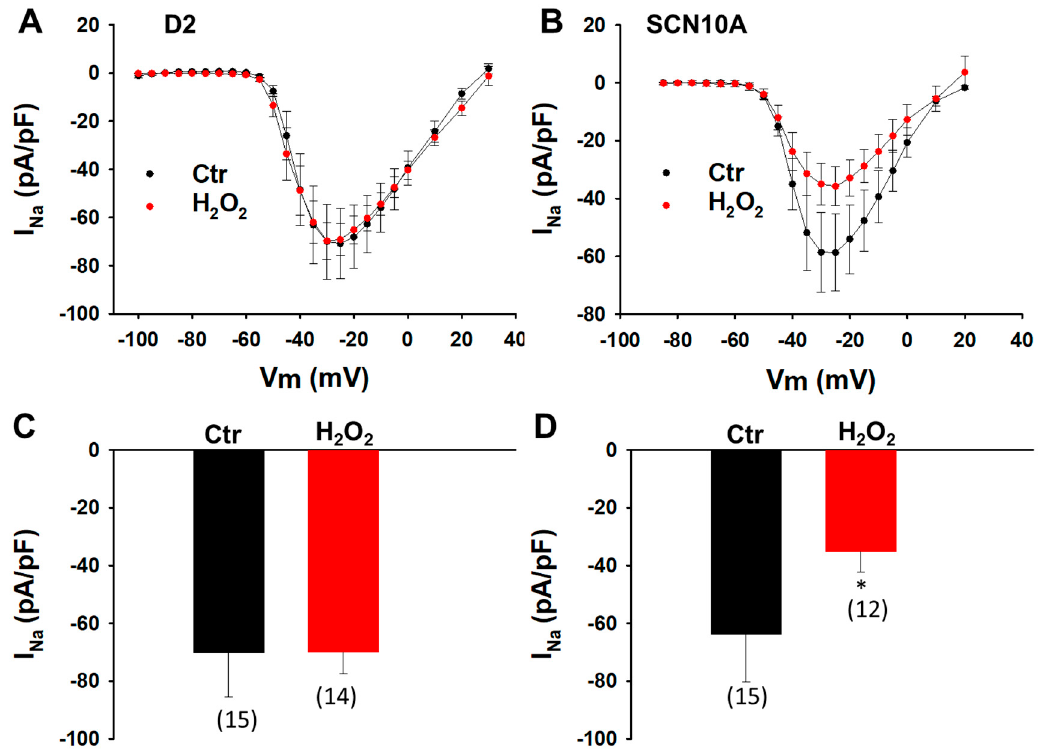
Figure 8. Peroxide (H 2 O 2 ) decreased the peak I Na in SCN10A cardiomyocytes. Cells were treated with vehicle (water, Ctr) or H 2 O 2 (200 μ M) for 2 h. ( A ) I–V curves of peak I Na in donor-hiPSC-CMs (D2) in absence (Ctr) or presence (H 2 O 2 ) of H 2 O 2 . ( B ) I–V curves of peak I Na in SCN10A-hiPSC-CMs (SCN10A) in absence (Ctr) or presence (H 2 O 2 ) of H 2 O 2 . ( C ) Mean values of peak I Na at − 30 mV in donor-hiPSC-CMs in absence (Ctr) or presence (H 2 O 2 ) of H 2 O 2 . ( D ) Mean values of peak I Na at − 30 mV in SCN10A-hiPSC-CMs in absence (Ctr) or presence (H 2 O 2 ) of H 2 O 2 . Values given are mean ± SEM. Numbers given in ( C , D ) represent the number of cells of measurements also for ( A , B ). * p < 0.05 versus Ctr according to t -test for two groups.